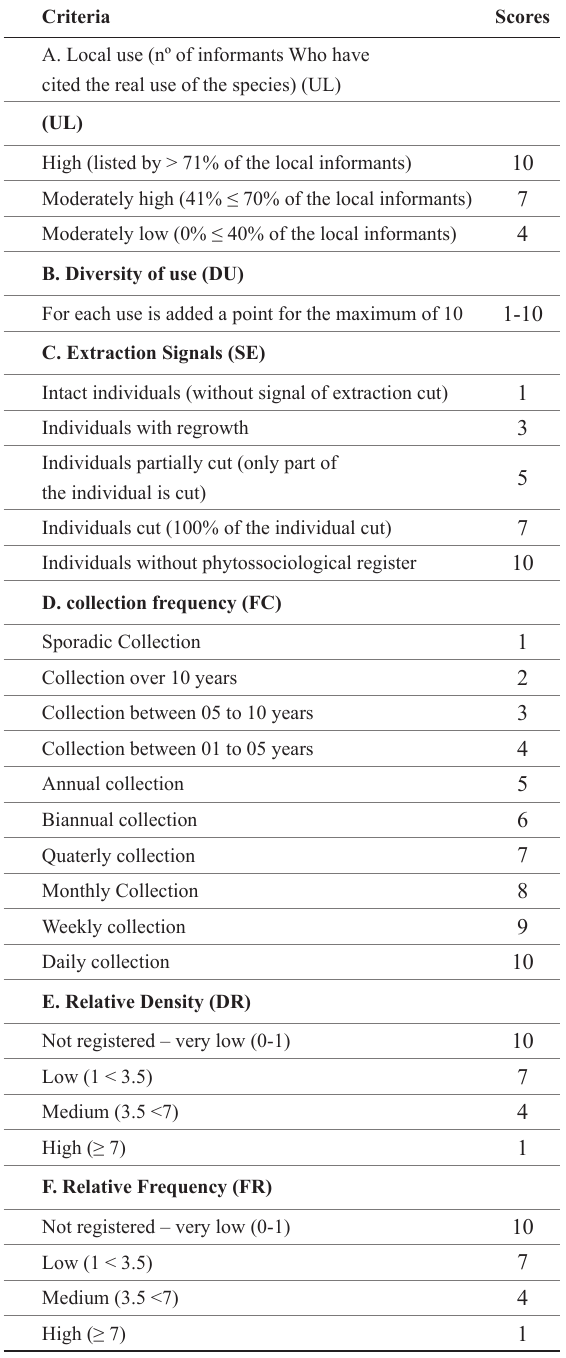
Scores used for the analysis of the conservation priority index (IPC) of the vegetation in the study area telling the local use (citation number of real use), use diversity, extraction signals, collection frequency, collected amount, density and frequency of the species (modified of Oliveira et al.